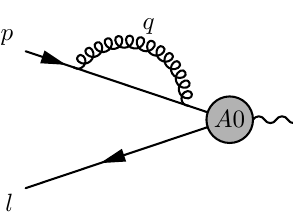
Figure 1 . Example of a threshold-collinear loop attached to the external PDF-collinear line together with a LP (A0) current. This diagram, and the ones with more loops attaching to the (anti)collinear leg, yield scaleless integrals and therefore vanish in dimensional